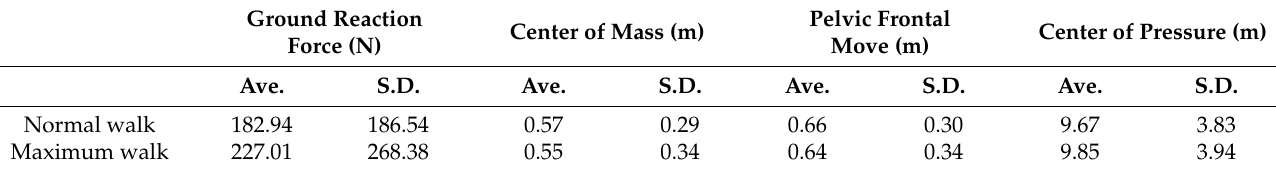
Table 8. Comparison of balance factor during the normal walking and maximum walking of ordinary individuals.